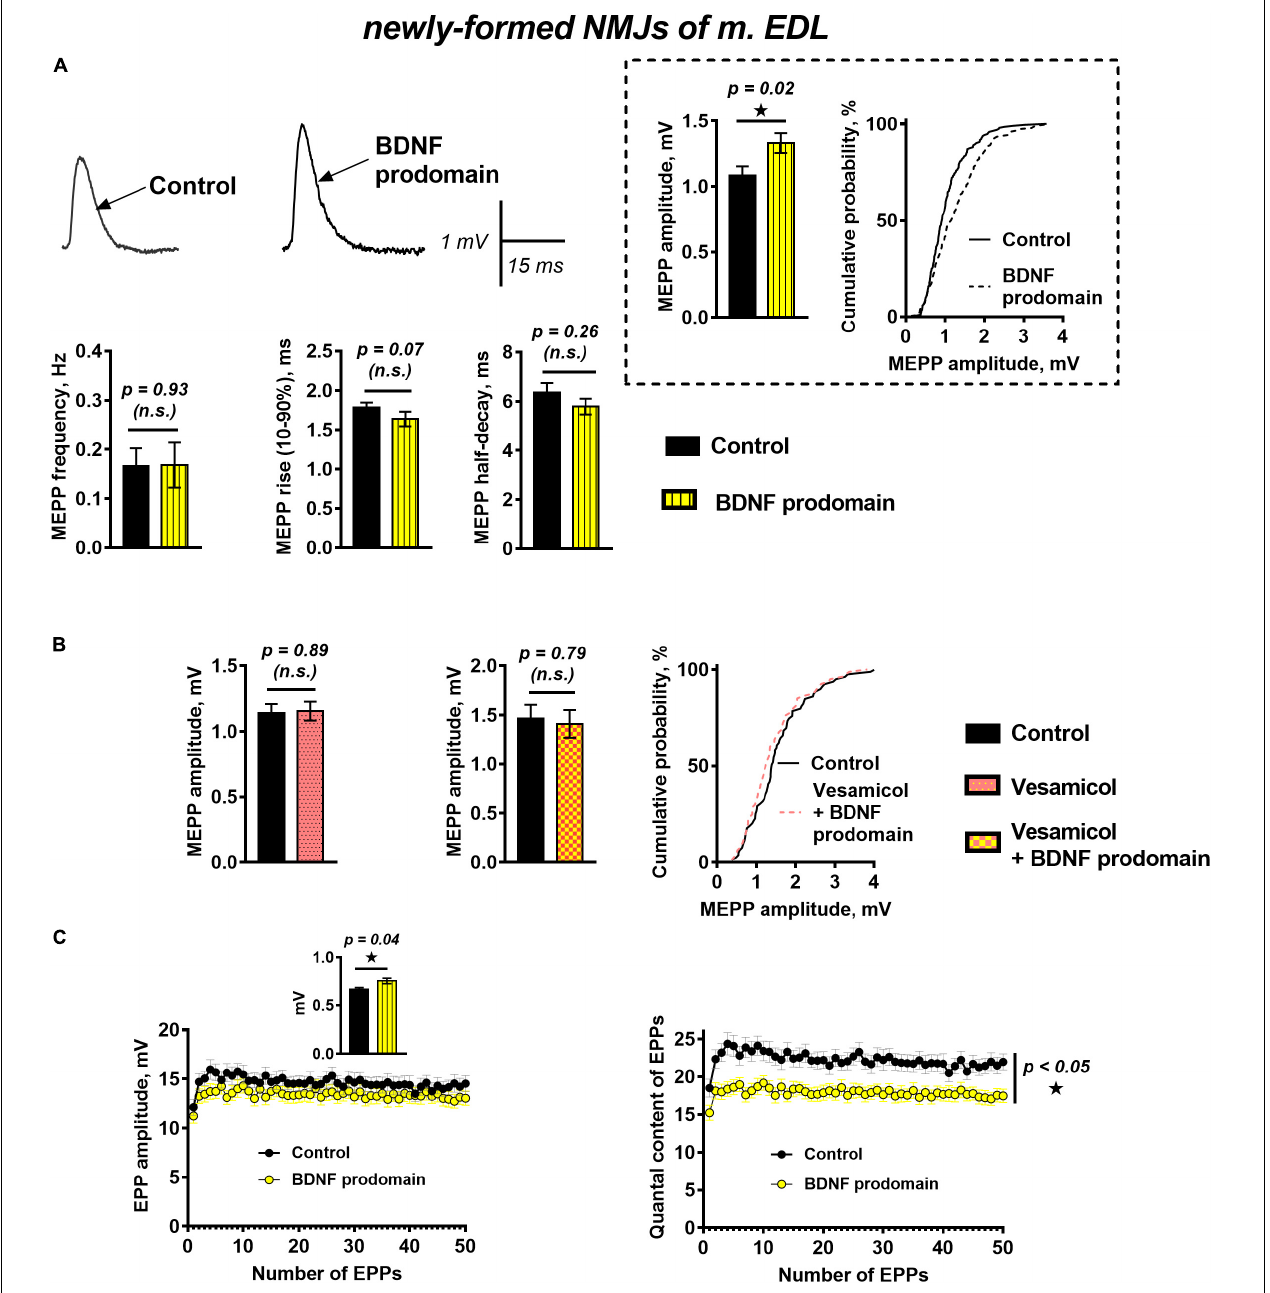
FIGURE 3 | BDNF prodomain in low concentration (1 nM) pre-synaptically increases ACh quantal size and simultaneously induces oppositely directed presynaptic effects affecting the evoked ACh release at newly formed NMJs of reinnervated mouse m. EDL. (A) Representative recordings of MEPPs (left above) and mean MEPP amplitude and cumulative probability plots (right above), frequency and time-course parameters (left to right below) in control ( n = 20) and upon application of BDNF prodomain ( n = 22). (B) Mean MEPP amplitude in control ( n = 16) and during inhibition of vesicular ACh transporter by vesamicol (1 µ M, n = 17) (left) and mean MEPP amplitude and cumulative probability plots in control ( n = 15) and upon application of BDNF prodomain in the presence of vesamicol ( n = 16). (C) Changes in the EPP amplitude (left) and their quantal content (right) in control ( n = 31) and in the presence of BDNF prodomain ( n = 41). Inset shows MEPP